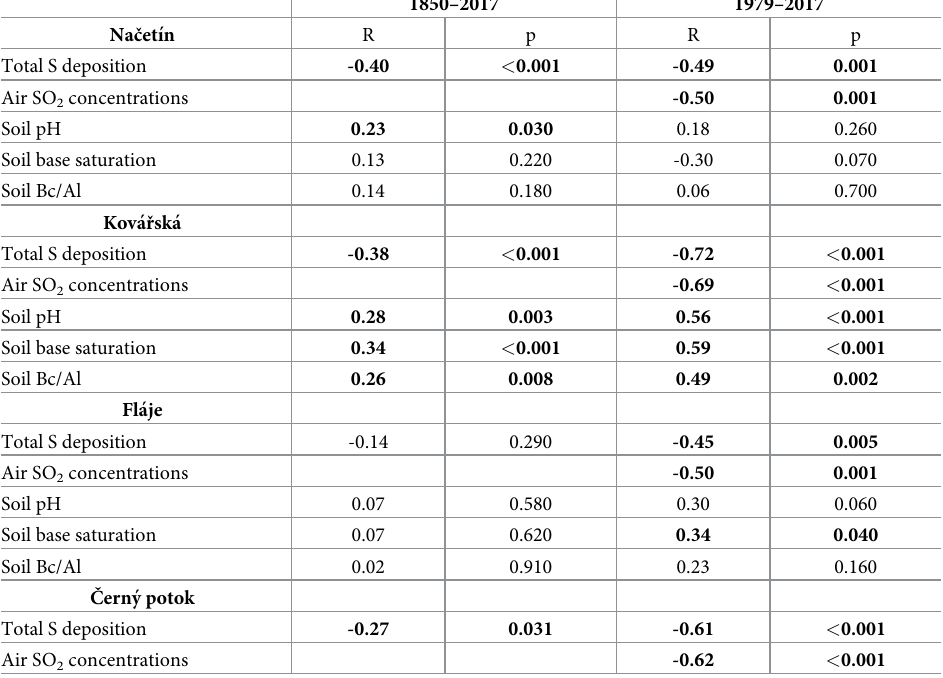
Table 4. Correlation coeficients between the individual parameters and TRW. Correlation was assessed during two intervals: (i) modelled annual atmospheric deposition and soil chemistry for the life span of trees and (ii) modelled annual soil chemistry, deposition and measured annual airborne SO 2 concentrations for the period 1979–2017. Statisti- cally significant (p < 0.05) values are displayed in